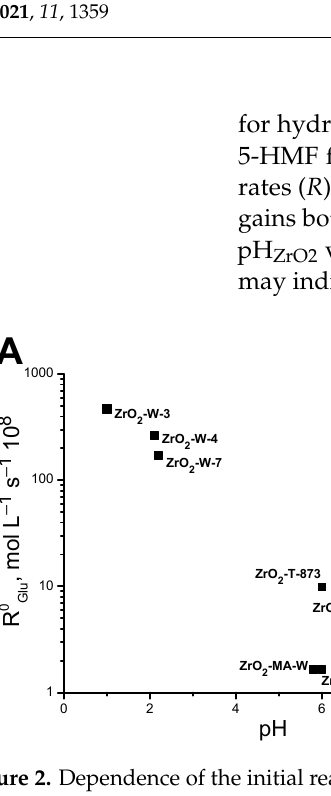
Figure 2. Dependence of the initial reaction rates of glucose ( A ) and 5-HMF ( B ) formation on pH of ZrO 2 suspension. Reaction conditions: initial concentrations of cellulose and catalyst 10 g L − 1 , reaction volume 45 mL, 453 K, P Ar 1 MPa, 1000 rpm, reaction time 7 h. TD—thermodegradation, W—microwave heating, MA—mechanical activation, SG—sol–gel method.